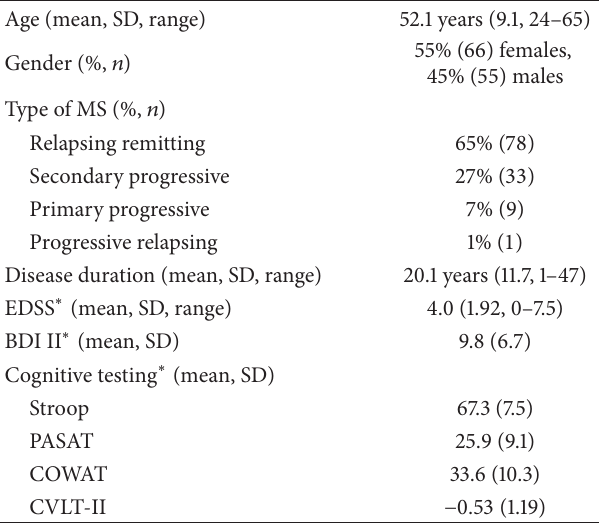
Table 1: Demographics and sample characteristics for the 121